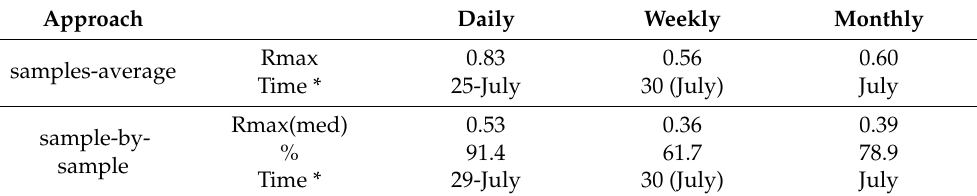
Table 3. Maximum correlation coefficient values between precipitation and black truffle production obtained in the Iberian Peninsula with the two approaches. For the sample-by-sample approach, Rmax refers to the median (med) values, and the corresponding percentage of R significant ( p < 0.05) values is also included. * Time (day, week or month) at which the maximum value is